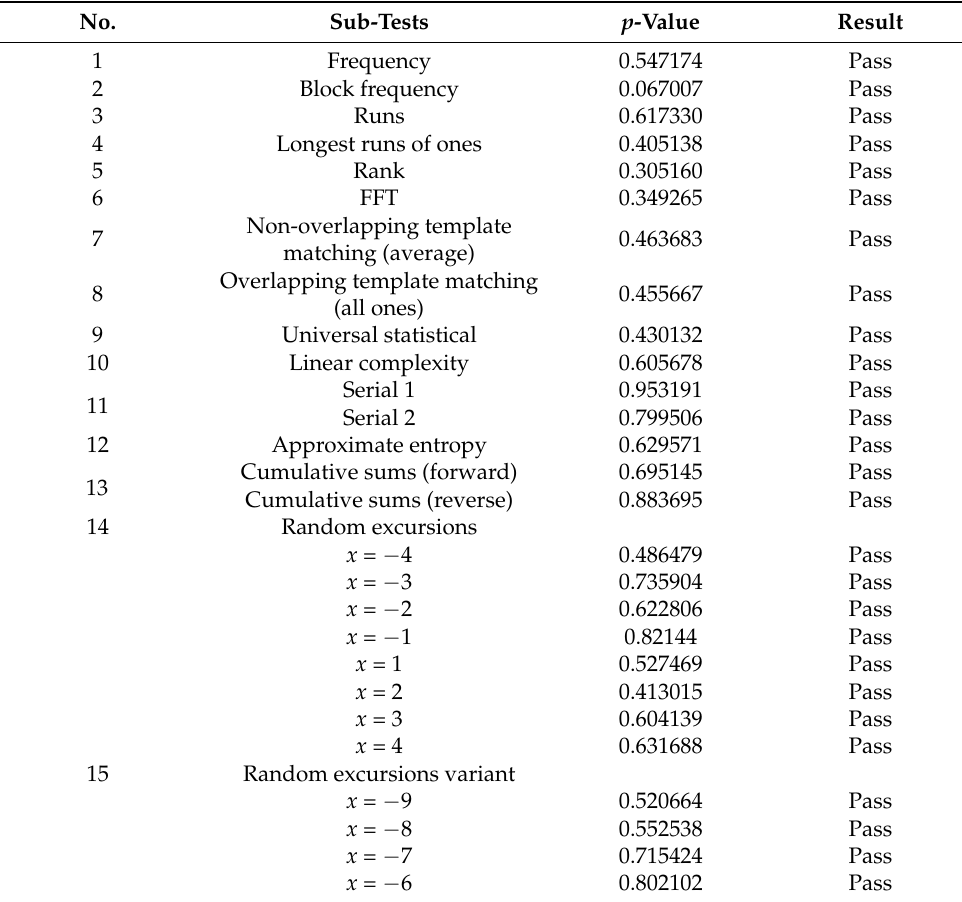
Table 3. Test results of NIST